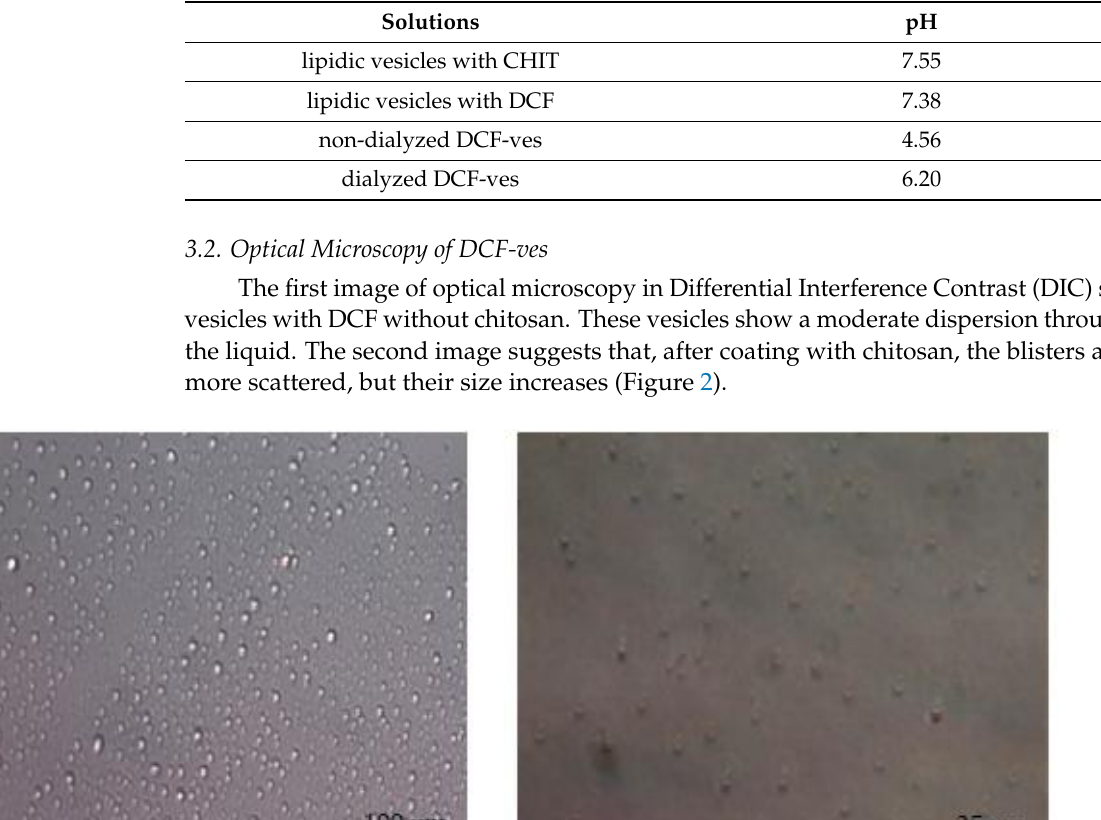
Table 1. pH values of suspensions with DCF.